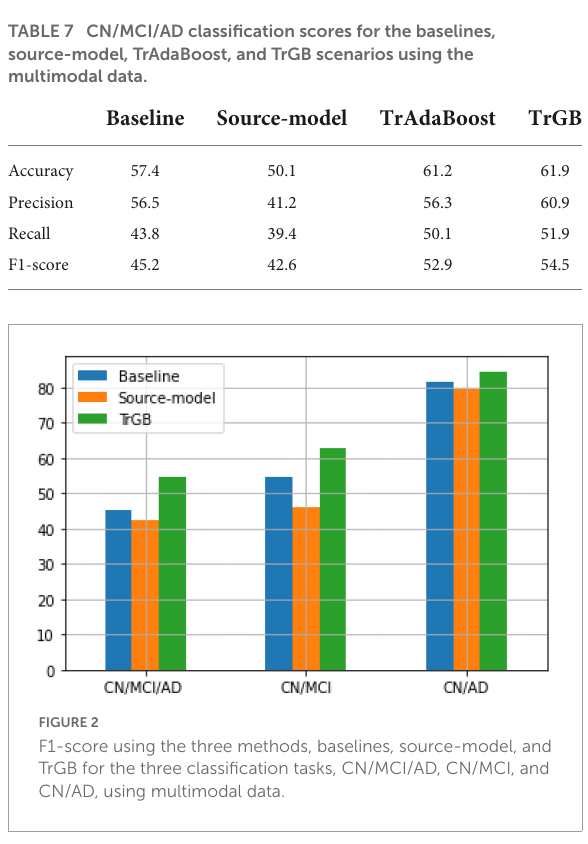
TABLE 4 CN/AD classification scores for the baselines, source-model, and TrGB scenarios for the PET modality.